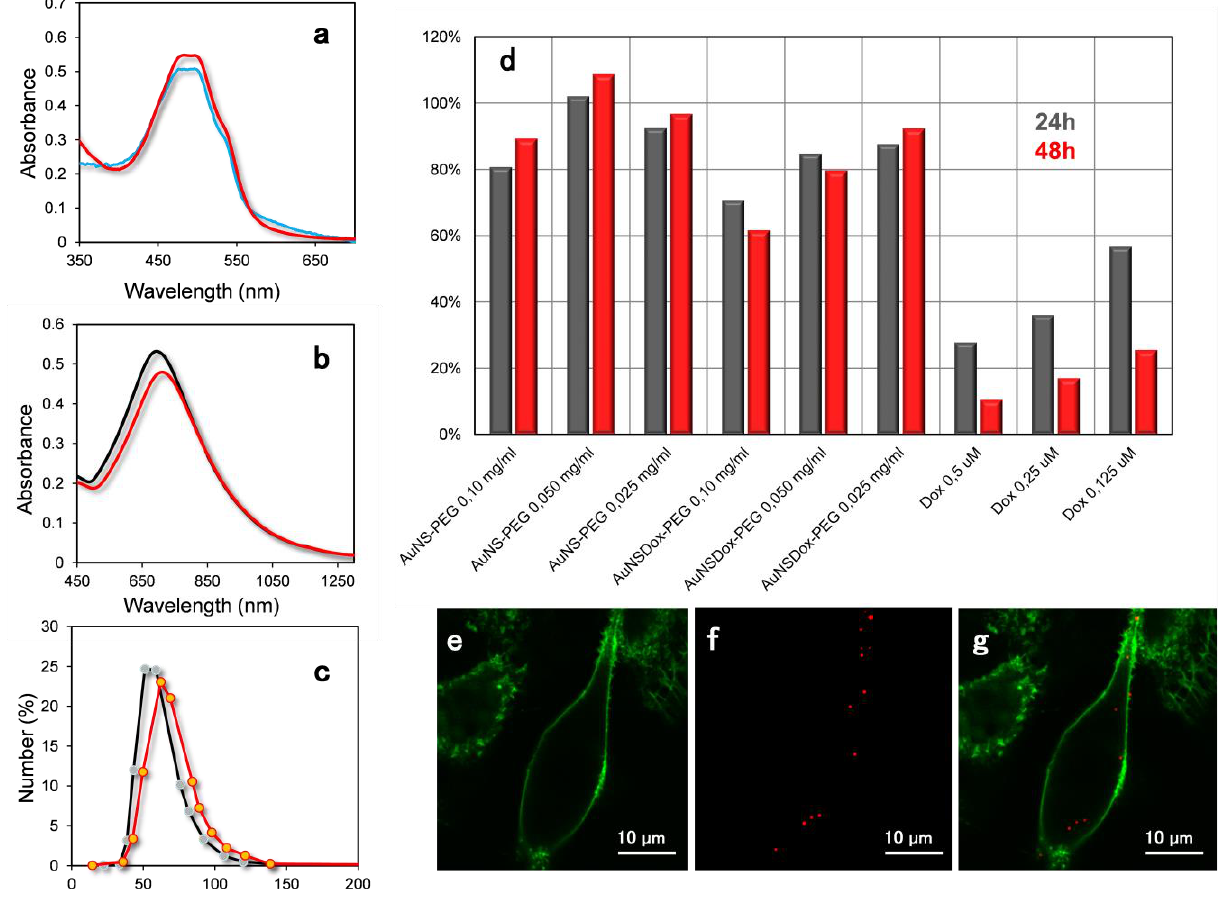
Figure 2. ( a ) UV–VIS spectra of Doxorubicin solution (red line) and supernatant obtained by the separation of the nanoparticles after 5 hrs of incubation with AuNS-PEG (blue line). ( b ) UV–VIS adsorption spectra of AuNS-Dox-PEG nanoparticles incubated in water (black line) and in PBS pH 7.4 (red line). ( c ) Dynamic Light Scattering analysis of AuNS-Dox-PEG nanoparticles incubated in water (black line) and in PBS pH 7.4 (red line). ( d ) Viability of A549 cell line incubated for 24 and 48 h with free doxorubicin, AuNS-PEG and AuNS-Dox-PEG at different concentrations (expressed in mass concentration of nanoparticles). Viability is expressed as fraction of the control (cells with complete medium). ( e – g ) Colocalization of gold nanoparticles inside living cell by LSCM. Green: fluorescence of the membrane stained with WGA-Alexa488. Red: Scattering of gold nanostars.